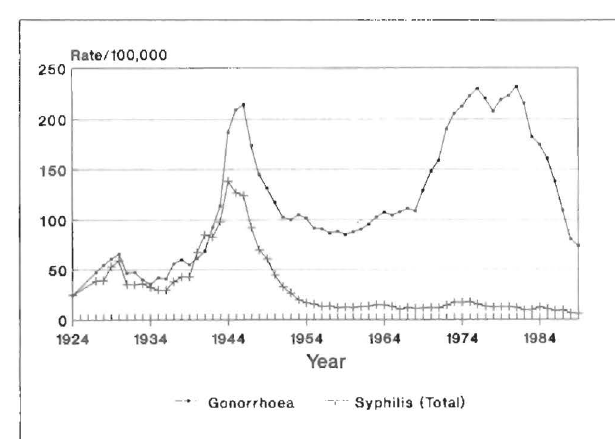
Figure 1) Trends in syphilis and gonorrhea cases